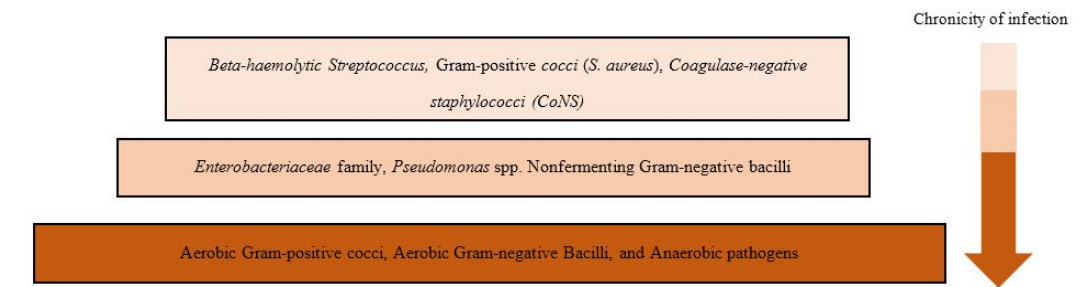
Figure 1. Bacterial diversity of diabetic foot infections in infection progression.